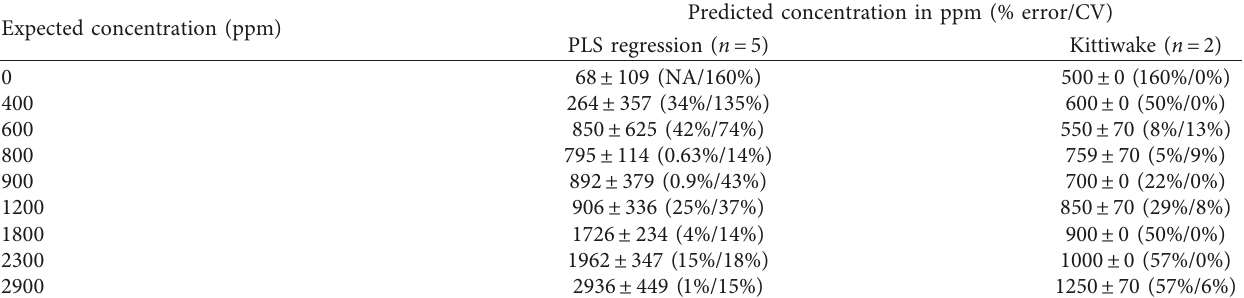
Table 4: Moisture concentrations predicted with PLSR using the spectral data at 1700–1600cm Kittiwake